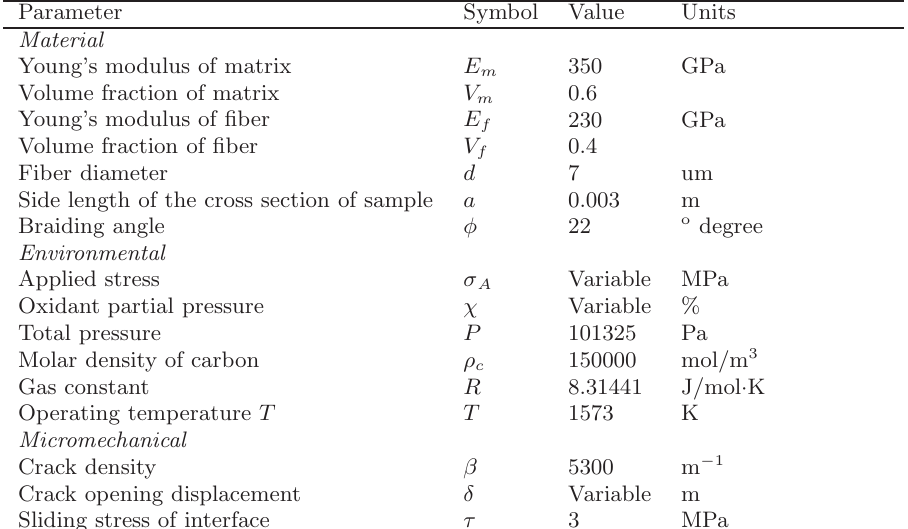
Table 1. Parameters and values used in calculation.